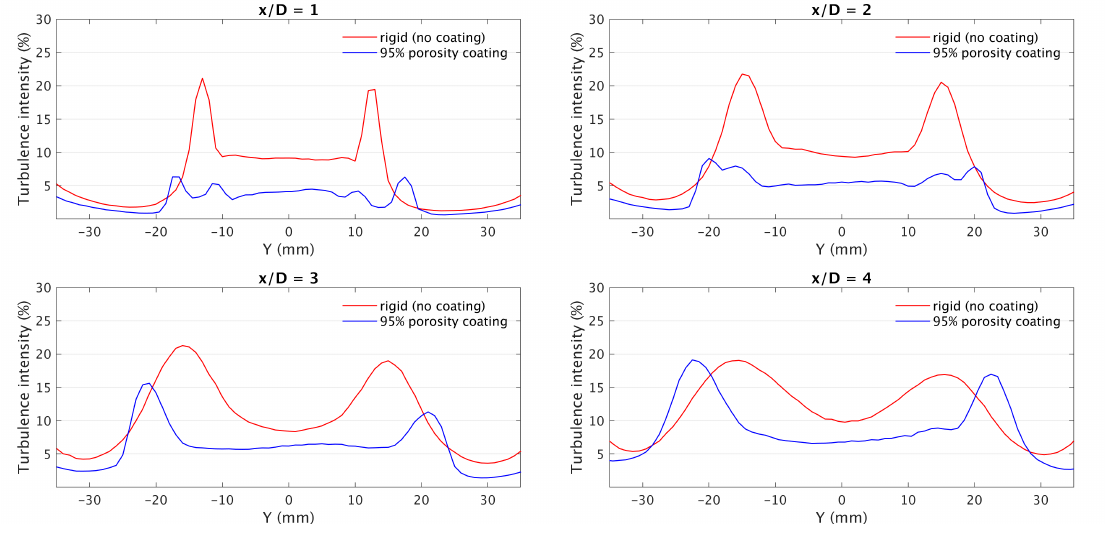
Figure 12. Turbulence intensity graph for cylinders 1 and